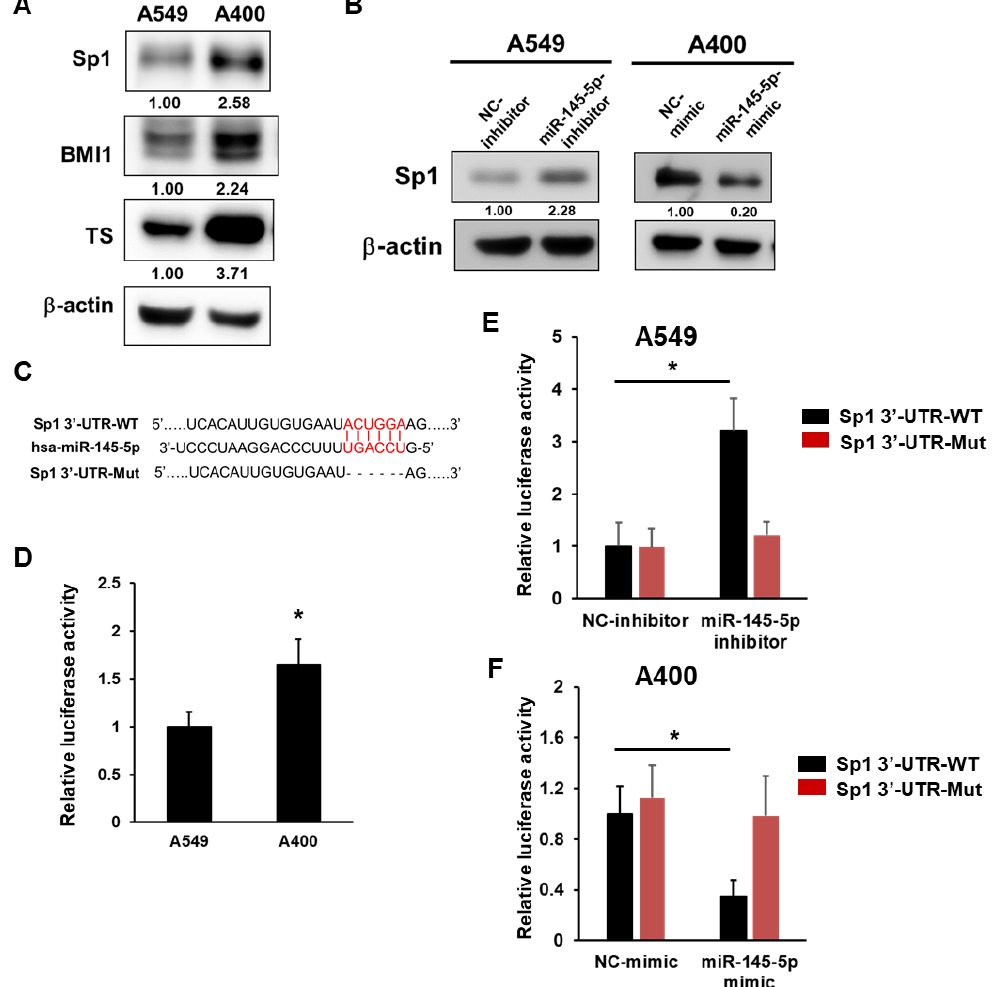
Figure 2. Sp1 is a direct target of miR-145-5p in the NSCLC cells. ( A ) The expression levels of Sp1, BMI1, or TS were determined by Western blotting. ( B ) The A549 or A400 cells were transfected with the miR-145-5p inhibitor or miR-145-5p mimic, respectively, and the expression level of Sp1 was determined by Western blotting. NC, negative control. ( C ) Alignments of miR-145-5p to wild type (Sp1 3 (cid:48) -UTR-WT) or mutant (Sp1 3 (cid:48) -UTR-Mut) of Sp1 3 (cid:48) -UTR. ( D ) A luciferase reporter vector containing Sp1 3 (cid:48) -UTR-WT sequences was transfected into A549 or A400 cells. The firefly luciferase activity was measured at 48 h post transfection and data were presented as the relative luciferase activity of A549 after being normalized with the RFP positive percentage. ( E ) A549 ( E ) or A400 ( F ) cells were transfected with the miR-145-5p inhibitor or miR-145-5p mimic, respectively, together with the Sp1 3 (cid:48) -UTR reporter vector simultaneously for 48 h. Luciferase activities were measured and presented as the relative level to negative control (NC) inhibitor/mimic group after normalization with the RFP positive percentage. * p <